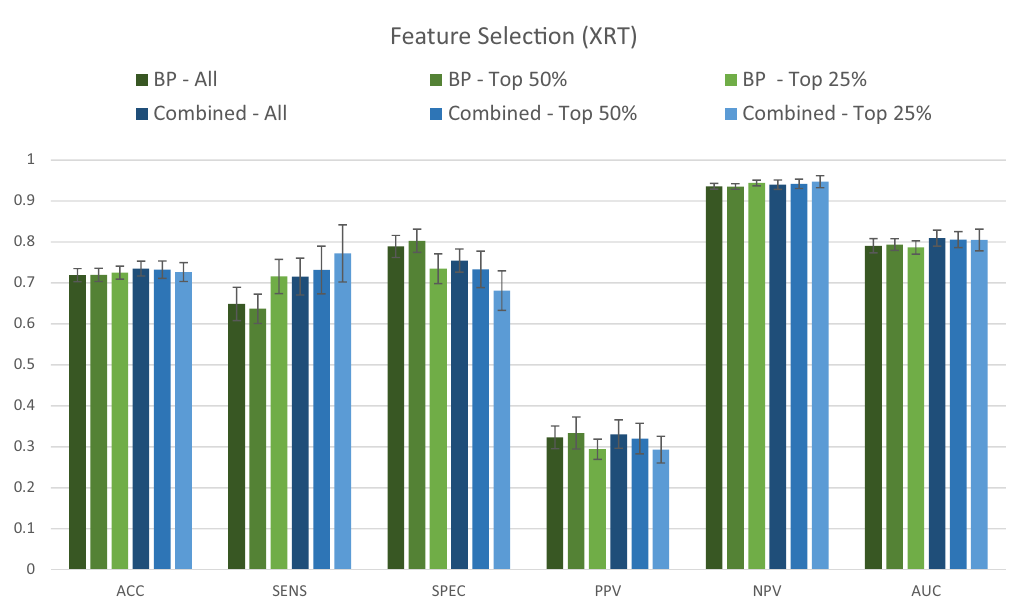
Figure 3. Comparative performance of the dataset containing only background, medical history and pregnancy-related variables (BP) and the combined dataset (BP + RS + SOC + VPSQ). The Extremely Randomized Trees (XRT) algorithm was used to compare the performance of the two datasets for predicting depression at 6 weeks postpartum. Models were assessed for accuracy (ACC), sensitivity (SENS), specificity (SPEC), positive predictive value (PPV), negative predictive value (NPV), and area under the curve (AUC). The variable selection procedure shows results when All (100%), Top 50%, and Top 25% of variables were retained, ranked according to Mean Decrease in Impurity (MDI)